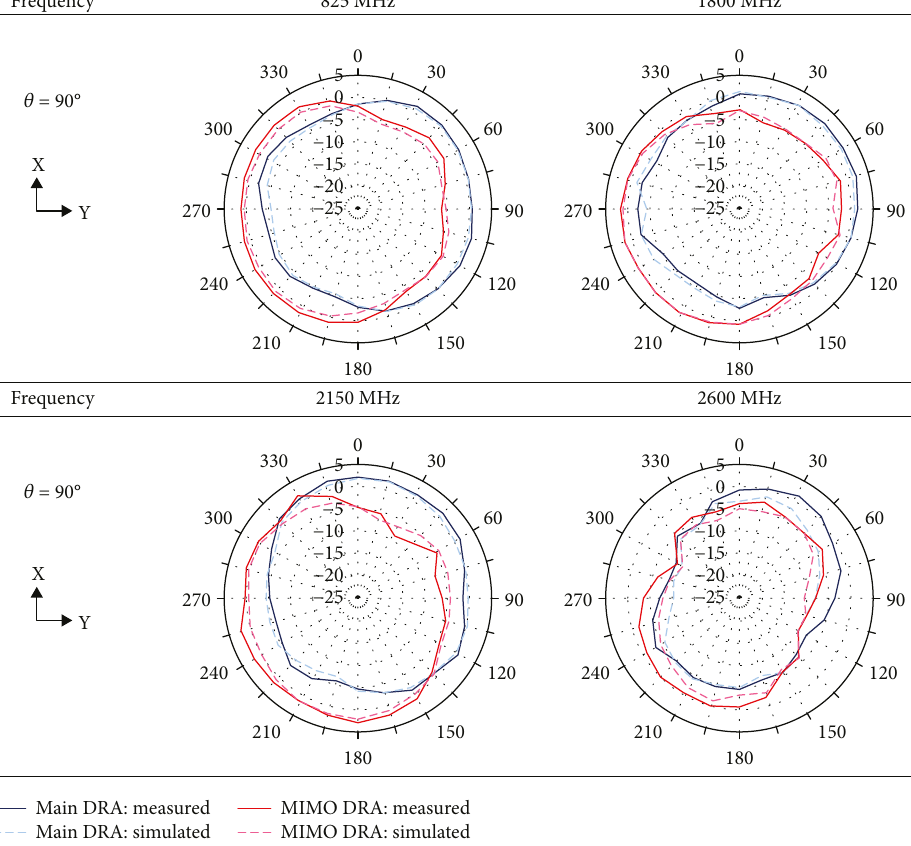
Figure 21: 2D radiation patterns of each DRA elements in the MIMO system.